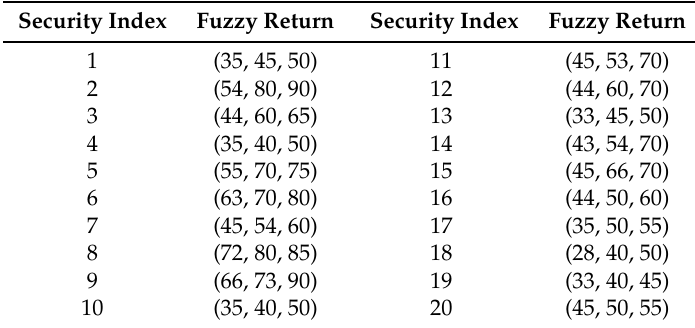
Table 2. Fuzzy returns for each security in the decision-making